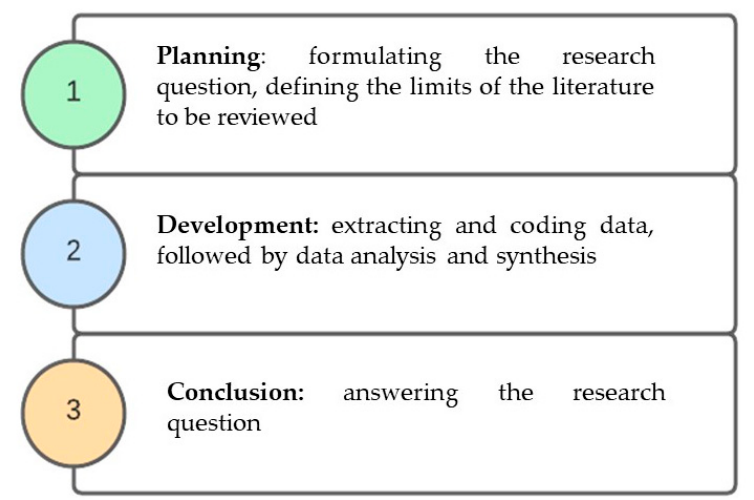
Figure 1. Protocol for selecting the